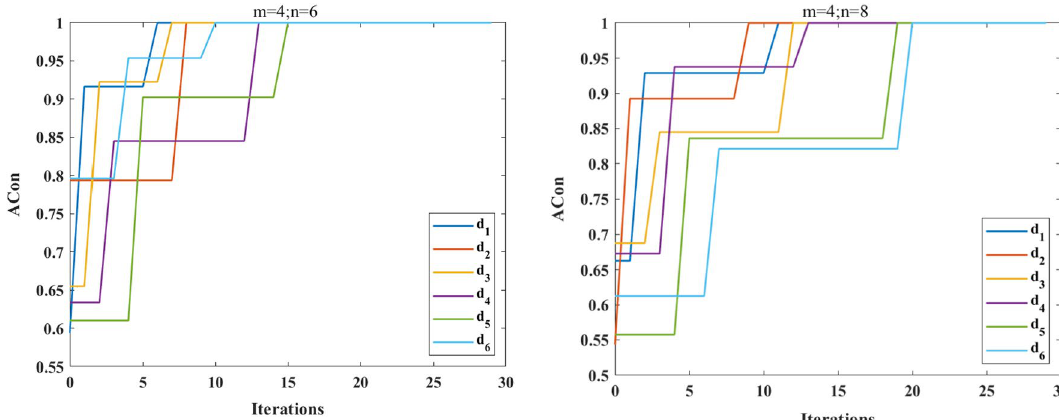
Fig. 5 Average self-confidence level under different iterations